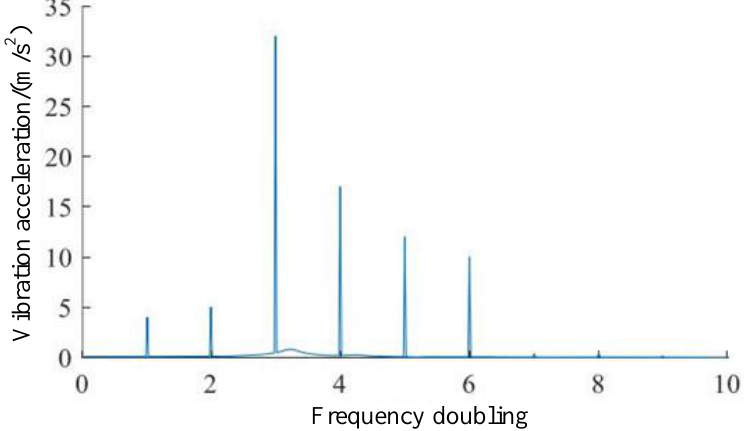
Figure 9. Frequency domain variation results of simulation vibration.